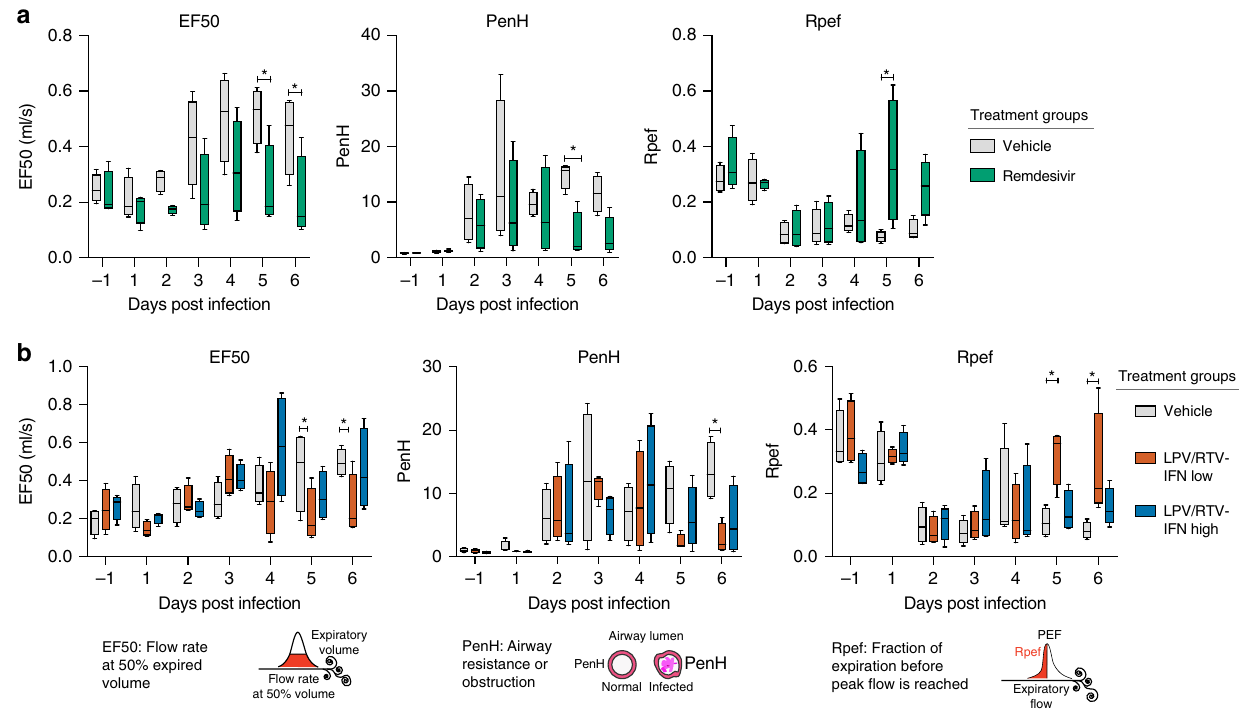
Fig. 6 Therapeutic RDV and LPV/RTV-IFNb improve pulmonary function. Whole-body plethysmography (WBP) was used to assess pulmonary function in mice. Representative WBP data for one of the two studies depicted in Fig. 5 are shown. All groups were N = 4 per day. EF50 is the fl ow rate at 50% expired volume. PenH is a surrogate measure of airway resistance. Rpef is the fraction of expiration before peak expiratory fl ow is reached. Altered EF50, PenH, and Rpef indicate bronchoconstriction or airway obstruction. Asterisks indicate statistical differences by two-way ANOVA with Sidek ’ s multiple comparison test in a and two-way ANOVA with Tukey ’ s multiple comparison test in b . The boxes encompass the 25th to 75th percentile, the line is at the median, while the whiskers represent the